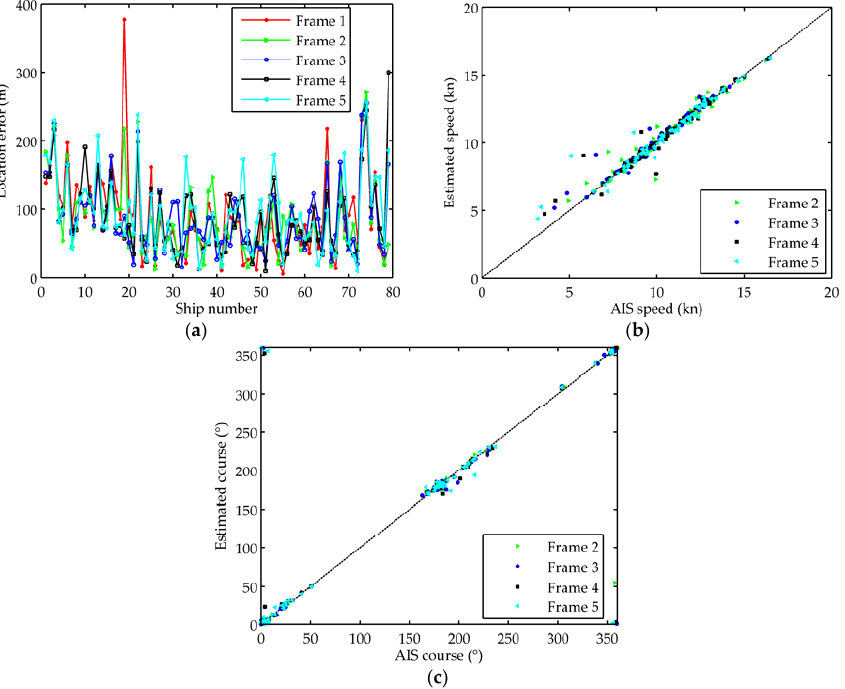
Figure 6. Comparisons of the motion estimation with AIS data. ( a ) Absolute error between estimated location and AIS location; ( b ) Estimated speed compared with AIS speed; ( c ) Estimated course compared with AIS course. Table 3. Average error of motion estimation.